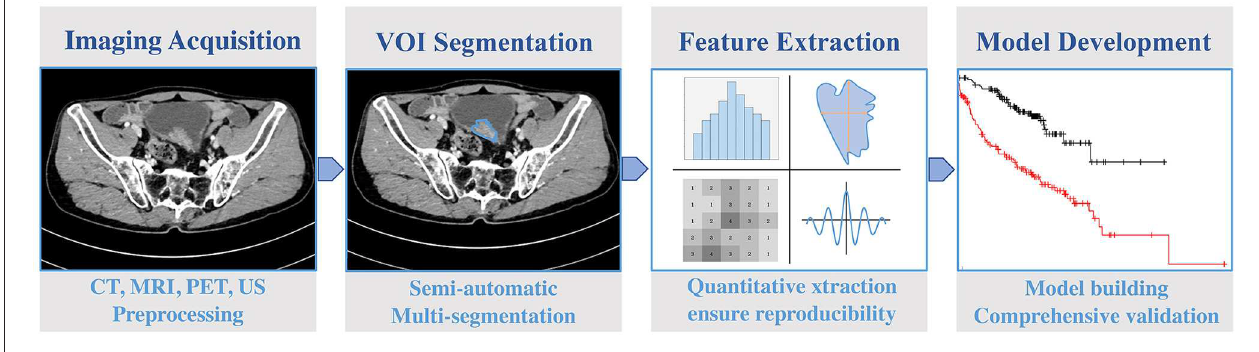
FIGURE 1 | A typical workflow of radiomics in bladder